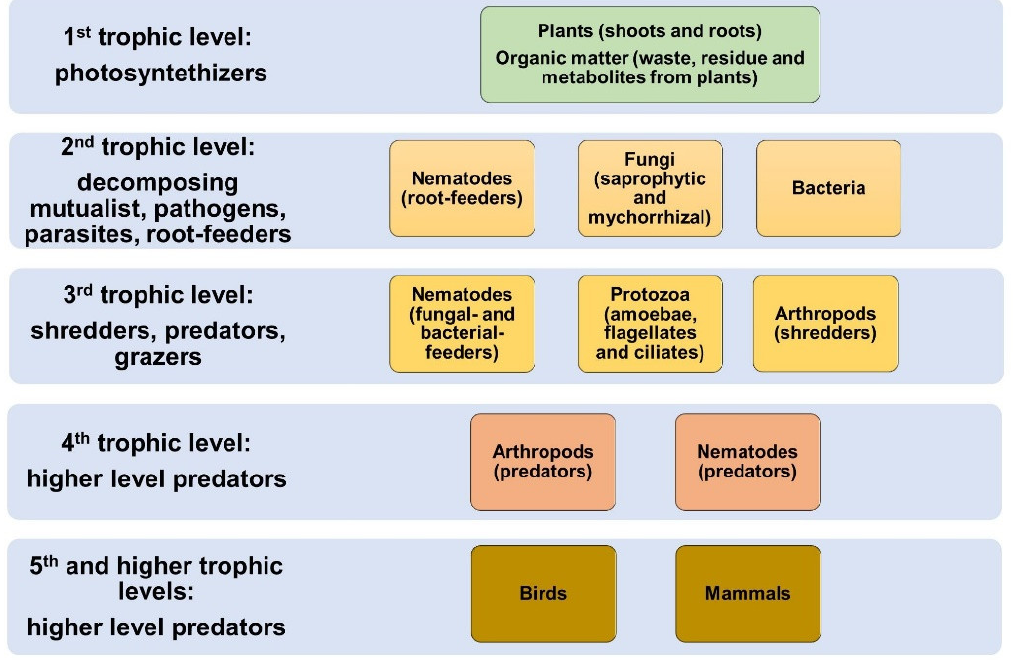
Figure 2. The hierarchical structure of the soil–food web.